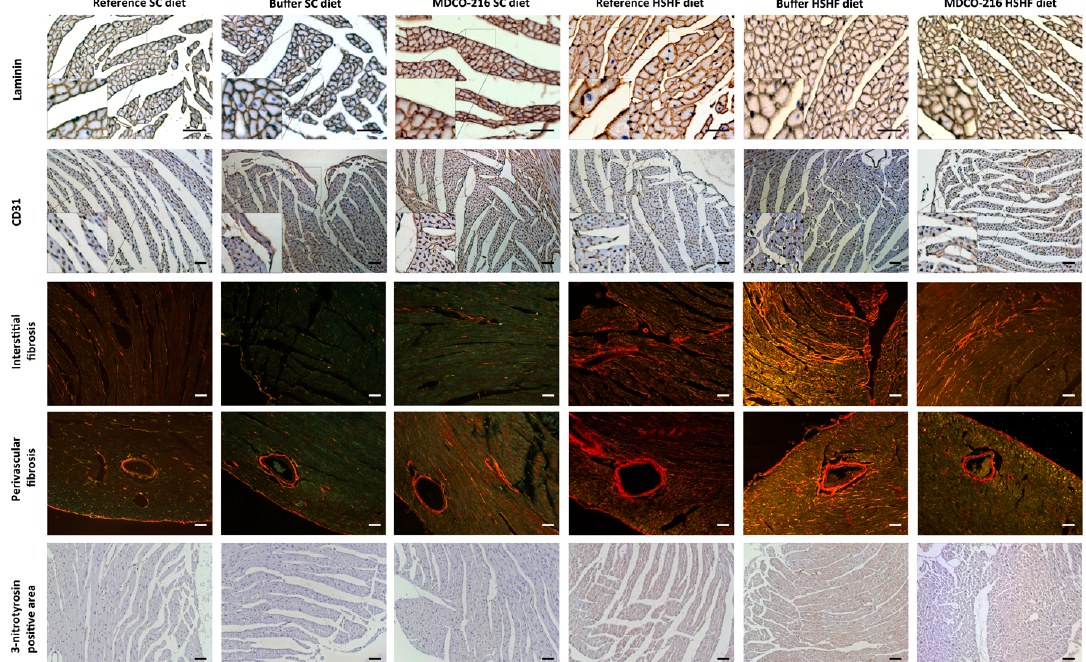
Figure 6. Immunohistochemical and histochemical analysis of the myocardium of reference, buffer, and MDCO-216 SC diet and HSHF diet mice. Representative photomicrographs show laminin-stained cardiomyocytes, CD31-positive capillaries, Sirius-red-stained collagen, and 3-nitrotyrosin positive area. Scale bar represents 50 µ